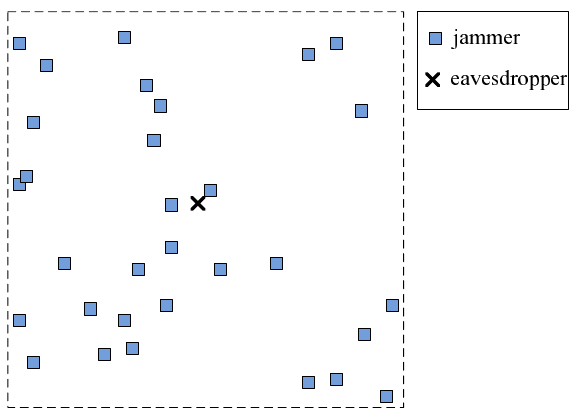
Figure 2. FJ-Ran Scheme: every jammer is randomly placed according to homogeneous Poisson Point Process (PPP). Note that we only show a part of the whole